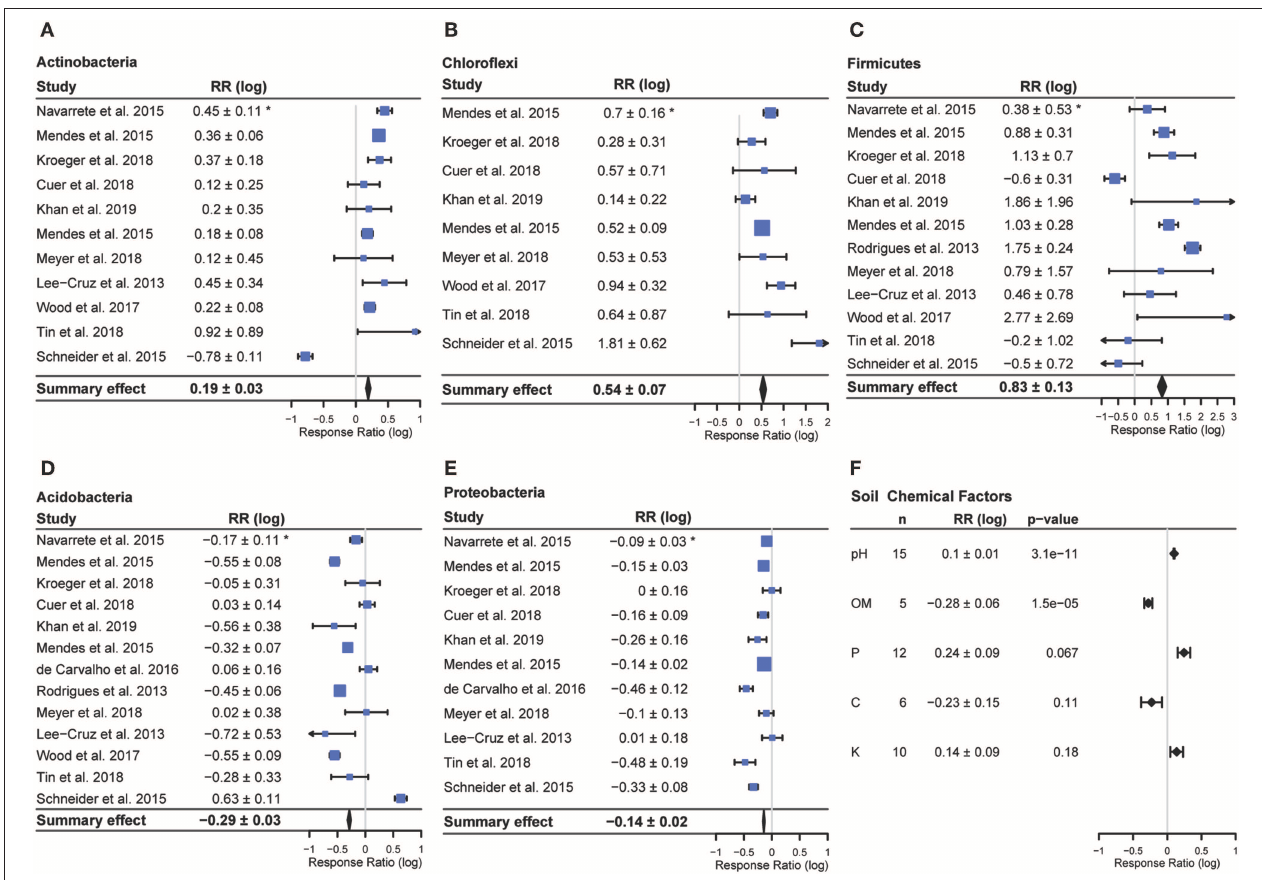
FIGURE 4 | Forest plot for each phylum with a significant summary effect (all p < 0.001) (A–E) and summary effects for soil chemical data (F) . Bars denote 95% confidence intervals, boxes are centered on means and box size corresponds to study weight for calculating summary effect. *Confidence interval (95%) of the response